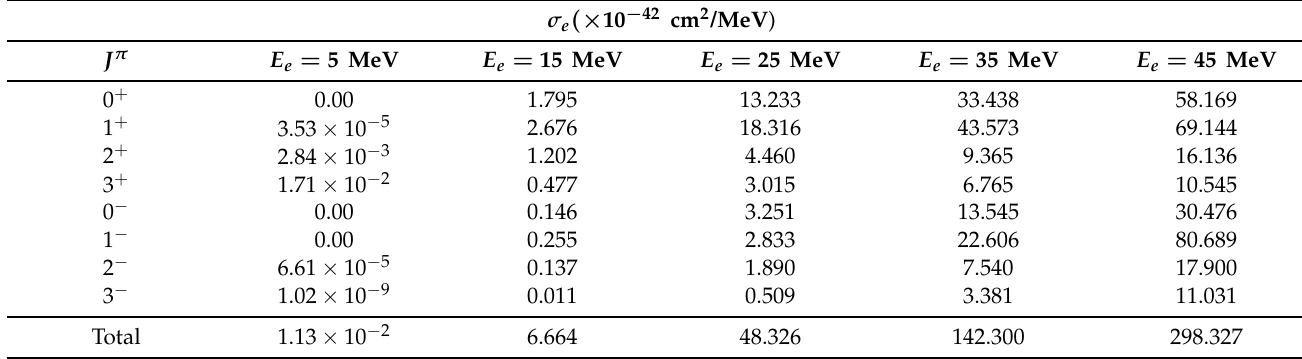
Table 1. Partial e − -capture cross-sections (in 10 − 42 MeV − 1 cm 2 ) on the 48 Ti isotope for some repre- sentative incident electron energy E e , accessible with different values for the hot stellar interior.